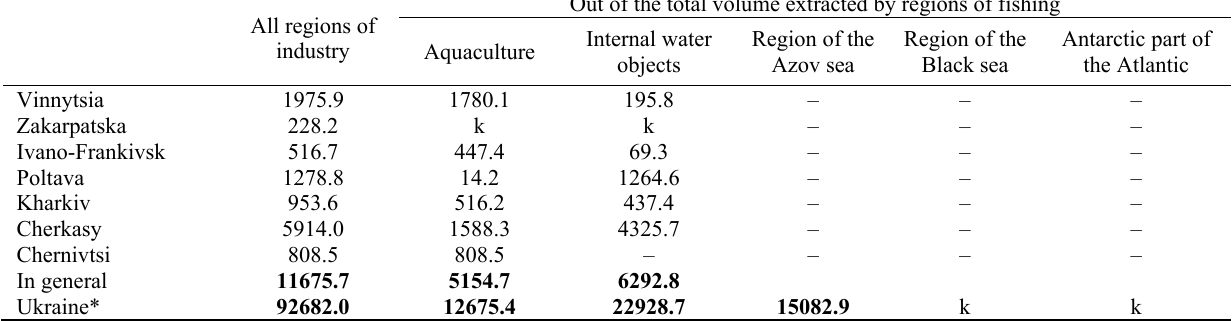
Total volume of harvested aquatic organisms in the IV zone of aquaculture of Ukraine in 2019, t (according to the State Statis- tics of Ukraine) (Derzhavna sluzhba statistiki Ukrayini) Out of the total volume extracted by regions of All regions of